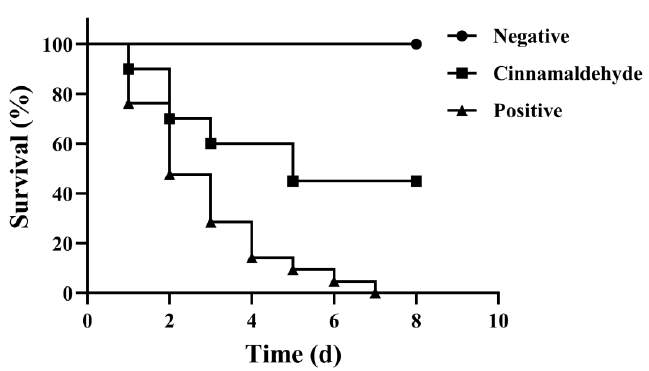
Figure 8. Cinnamaldehyde can increase the survival rate of crucian carp infected with A. hydrophila . Infected crucian carp were administered with 25 mg/kg of cinnamaldehyde or sterile PBS every 12 h for 3 days; deaths were recorded for 8 days. Treatment with cinnamaldehyde had a significant protective effect on crucian carp infected with A. hydrophila when analyzed by log-rank test ( p < 0.0001).